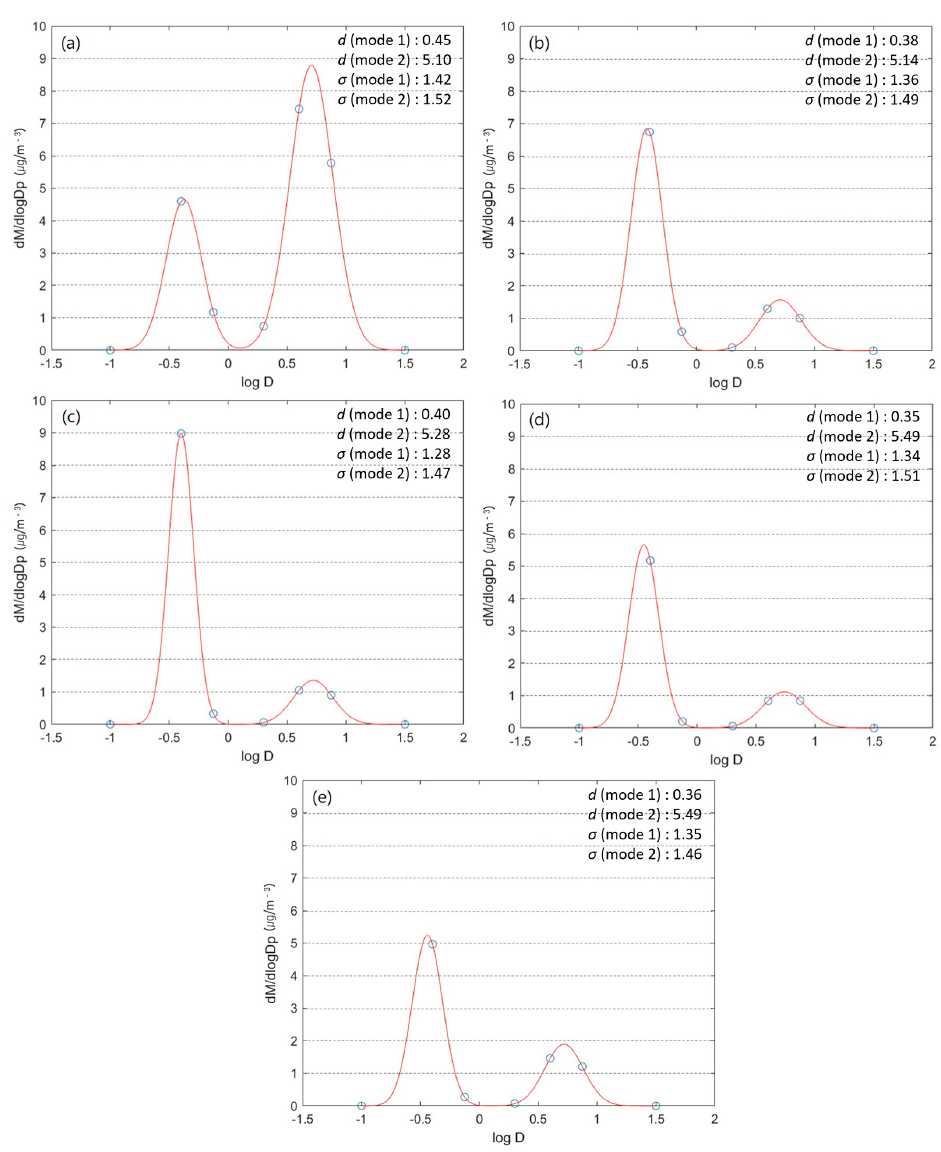
Figure 8. Logarithmic probability density function for mass concentration versus particle diameter (D) for the following: ( a ) Asian dust (AD), ( b ) haze (HZ), ( c ) mist (MI), ( d ) precipitation (PR), and ( e ) clear days (CD) cases. Red lines show the optimum regression curve. d is the geometric mean diameter, and σ is the geometric standard deviation.